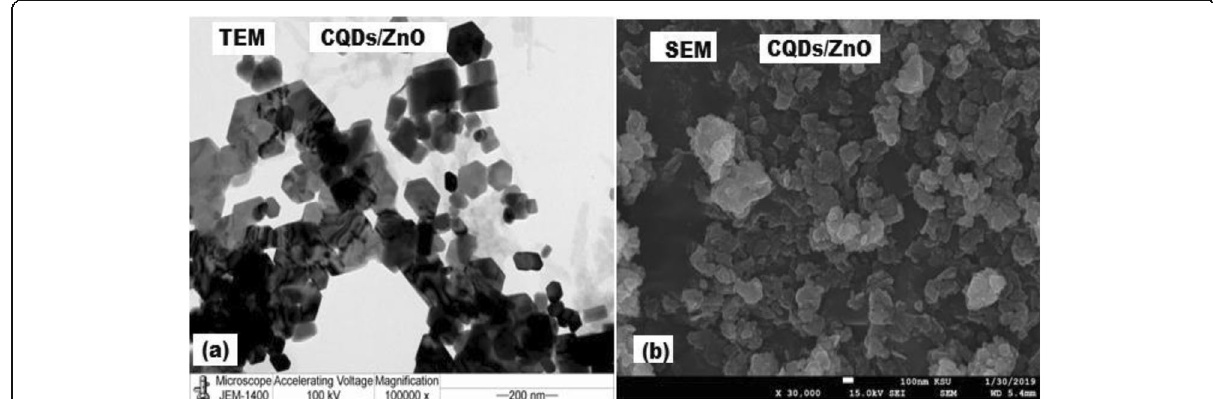
Fig. 2 a and b represent the transmission electron microscope and scanning electron microscope images of CQDs/ZnO nanocomposite